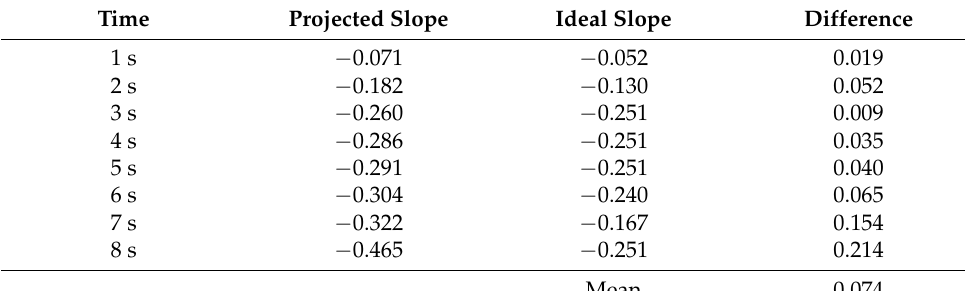
Table 3. Differences between projected and ideal slopes. Time Projected